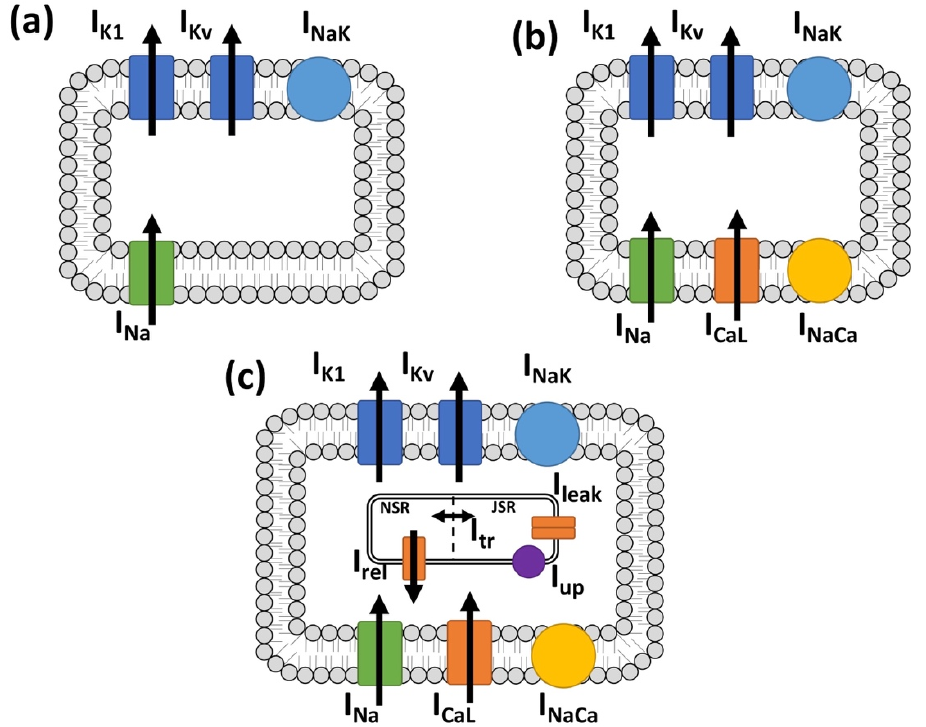
Figure 1. Three different cellular models to explore the effects of myofibroblast Ca 2+ handling. ( a ) Baseline myofibroblast model without Ca 2+. ( b ) Myofibroblast model including the L-type Ca 2+ current. ( c ) Myofibroblast model including the L-type Ca 2+ current and an intracellular Ca 2+ handling system.